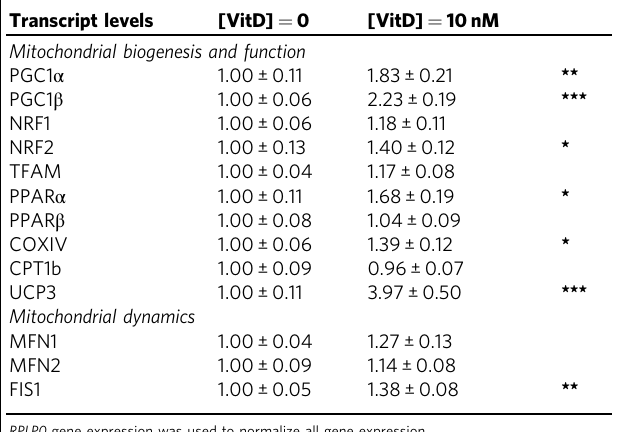
Table 2 Expression of genes involved in mitochondrial biogenesis and dynamics in C2C12 myotubes treated with vehicle or 10 nM of 1,25(OH) 2 vitamin D 3 for 72